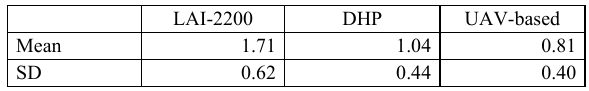
Table 7. Summary of mean values and standard deviations of LAI eff of all optical